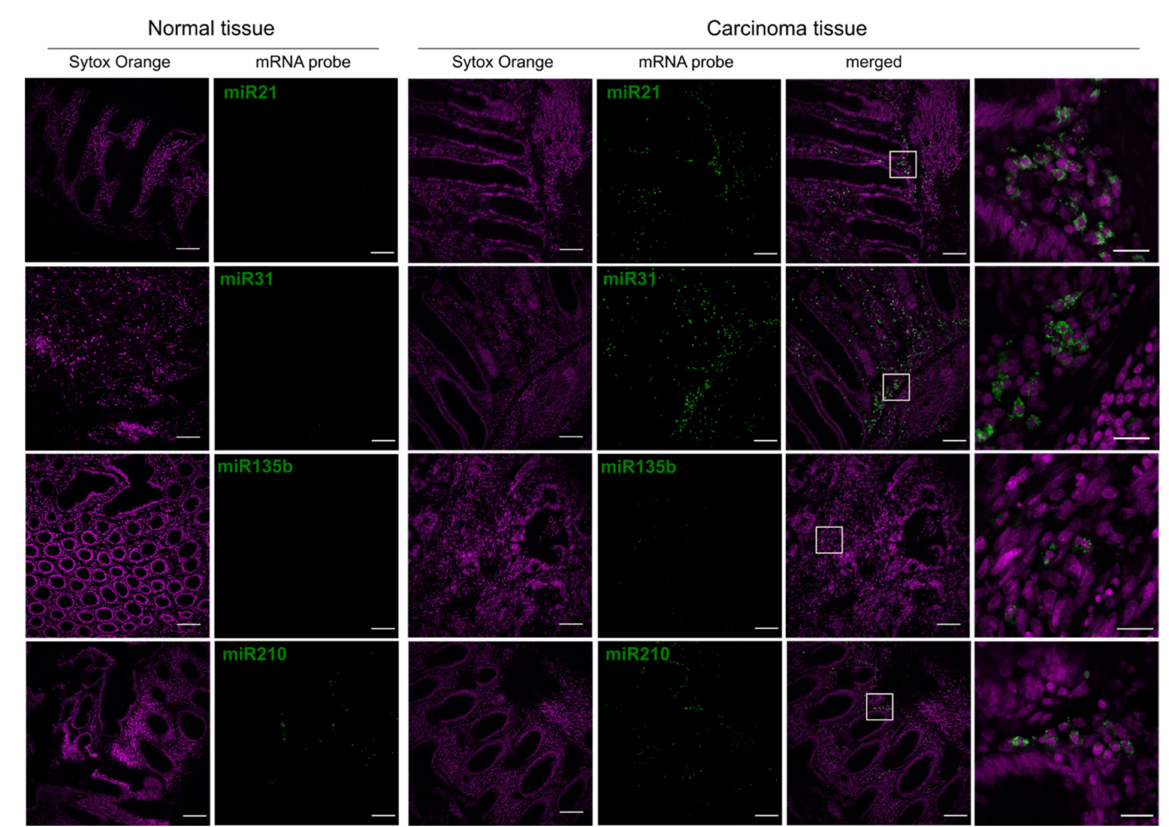
Figure 8. Representative confocal images of FISH performed at normal and carcinoma colorectal human tissue samples with various pro-metastatic miRNA probes: miR-21, miR-31, miR-135b, and miR-210. Green signals correspond to the Cy5 on the miRNA probe, and purple signals represent the nuclear stain by Sytox Orange. The last column shows magnifications of the areas delineated in white rectangles within the second last column (merged images of carcinoma tissue). The brightness range (0–255) of images with miR signals (except the last column) was re-set to 5–100 for this figure alone to enhance the contrast. Quantification of miRNA signals can be found in Figure 9. Scale bars: 100 µ m. Scale bars for the last column: 20 µ